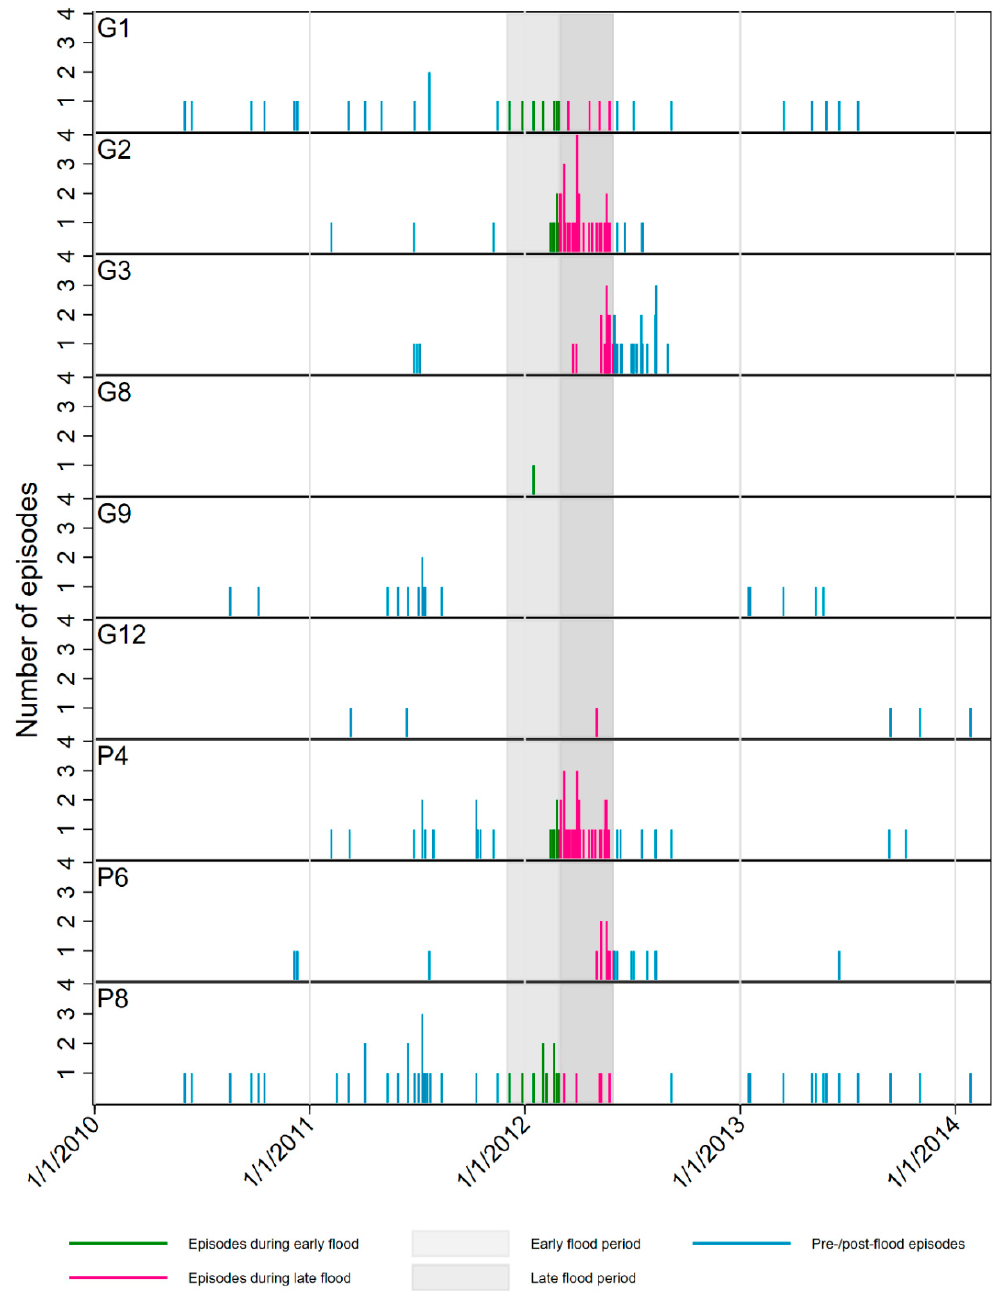
Figure 6. Needle plots of the daily distribution of rotavirus-positive stool samples recorded at the MAL-ED Peru site by genotype.